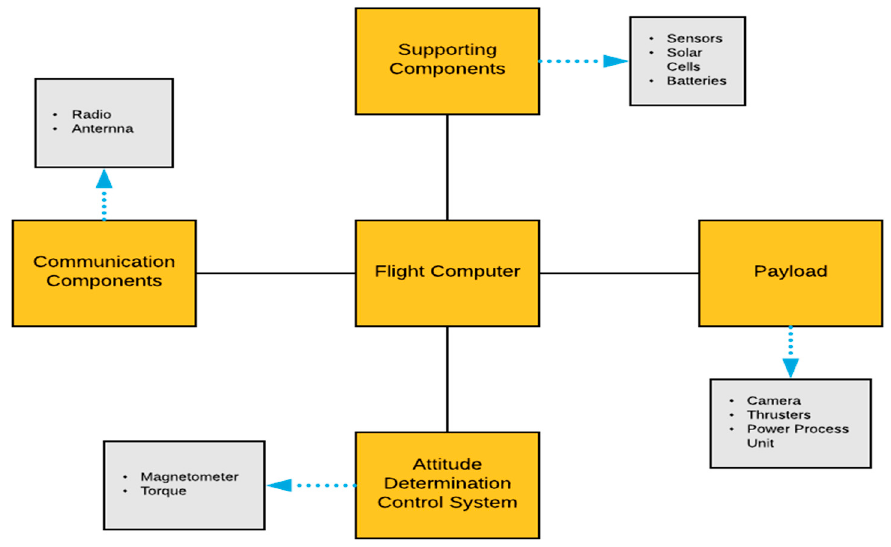
Figure 9. A block diagram of a CubeSat subsystem’s components.